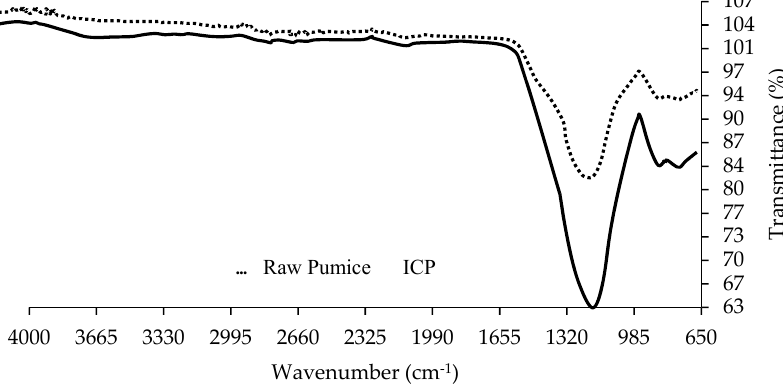
Figure 3. FT ‐ IR spectrum of raw and iron ‐ coated pumice samples.